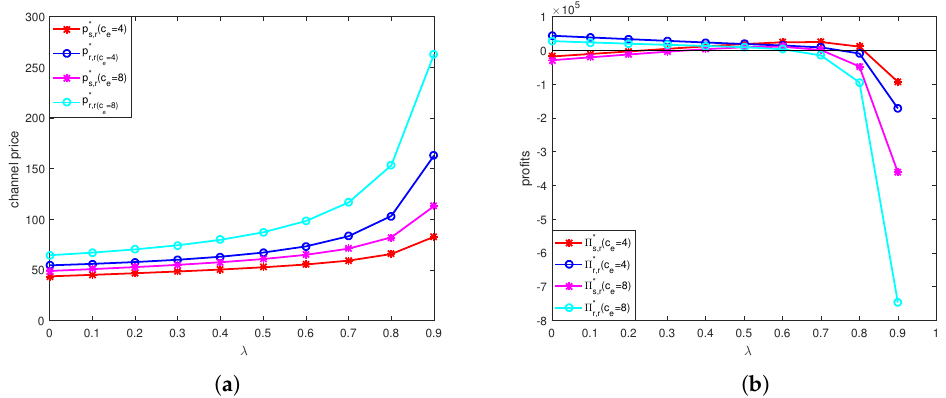
Figure 7. Optimal selling price and profit in offline channel supply chain: ( a ) Optimal selling price in online channel supply chain. ( b ) Optimal profit in offline channel supply